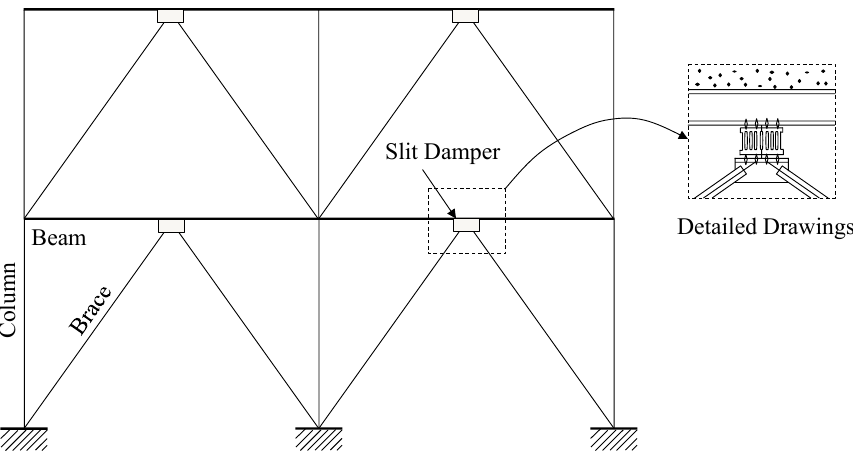
Figure 2. Installation of the slit damper device in the concentrically braced frame.